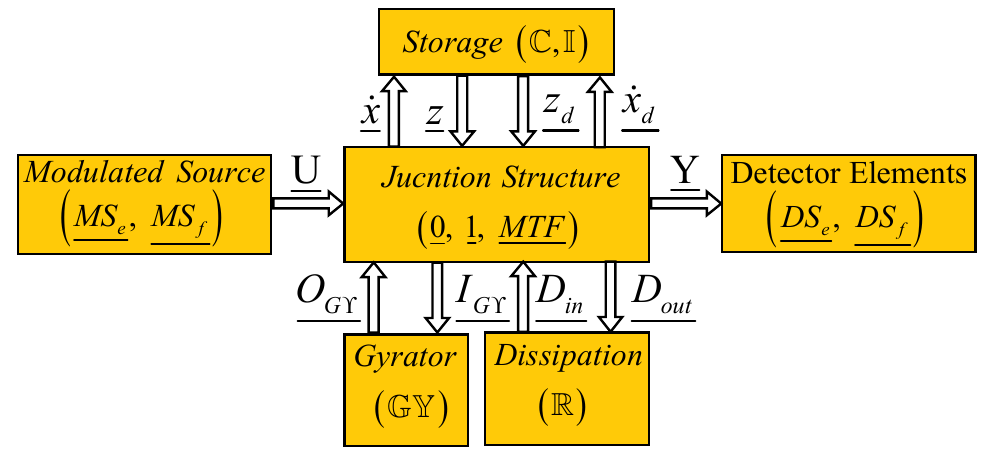
Figure 8. Eulerian junction structure: ( a ) Euler ring; ( b ) multiport gyrator. Fig. 6 . Eulerian junction